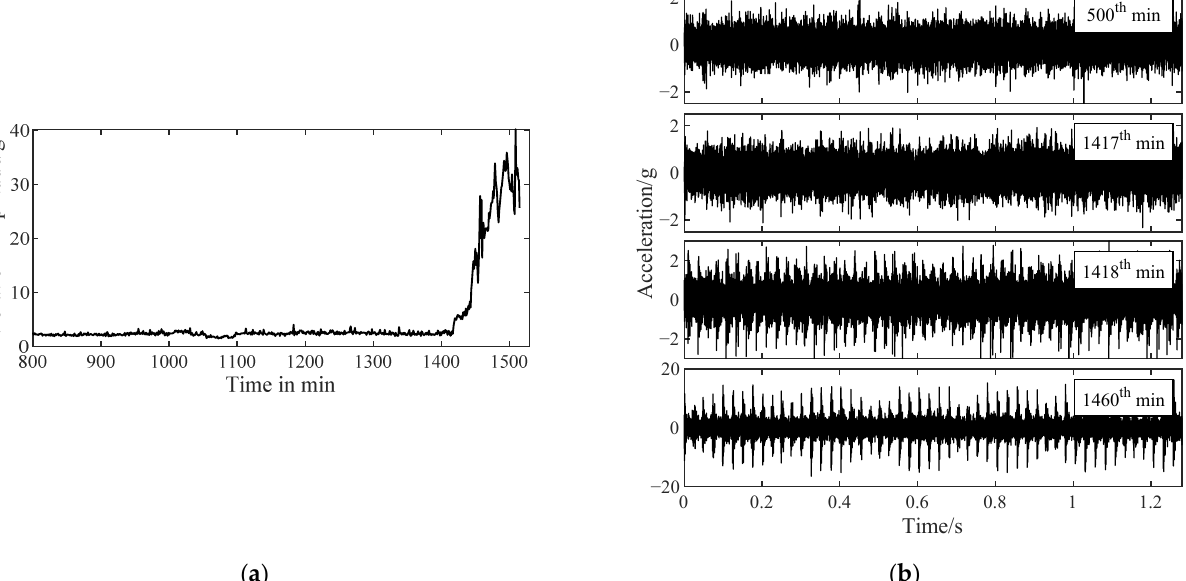
Figure 14. Vibration data of bearing 4 with a developing inner ring fault. ( a ) The curve of maximum vibration amplitude versus time; ( b ) vibration signals measured at 500th/1417th/1418th/1460th min. Improved TKEO was applied to the signals in Figure 14b, with its parameters set as α = 0.05 and δ = 0.1. Fourier spectra |F ψ [ ˆ x e ] | obtained with improved TKEO are shown in Figure 15. The rotating frequency f 1 = 40Hz and the inner ring fault characteristic frequency f bfi = 196.7Hz. The gray dashed lines represent f bfi or its higher harmonics f bfi . The gray dotted lines present n f bfi ± f 1 and n f bfi ± 2 f 1 , which are the frequencies modulated by n f bfi and f 1 . Similar to the development of the outer ring fault, there is no frequency component related to f bfi in the analysis result of the vibration signal sampled